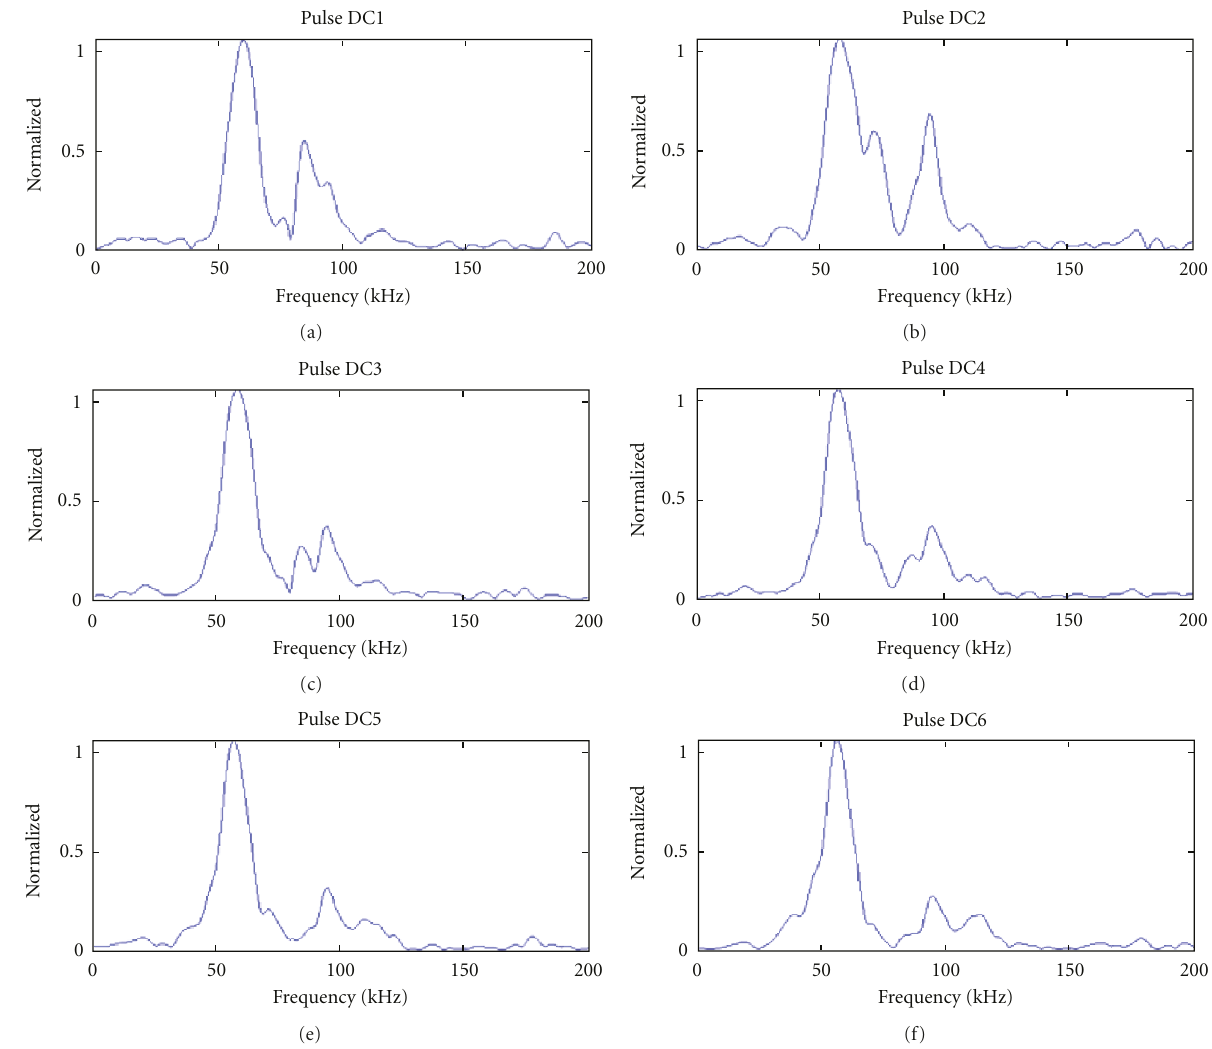
Figure 10: Spectral responses for SL17L cable D on coarse sand, 27 ◦ grazing angle, DC1–6.